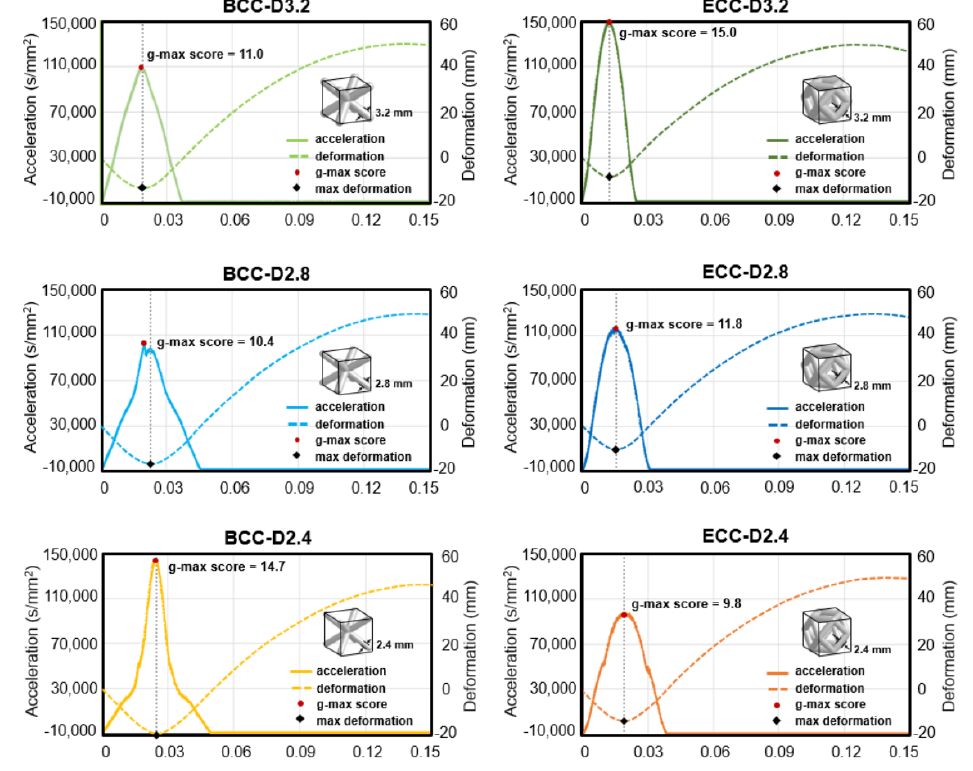
Figure 8. The acceleration-time and deformation-time curves of the sandwich structures with six types of lattice core under dynamic impact. types of lattice core under dynamic